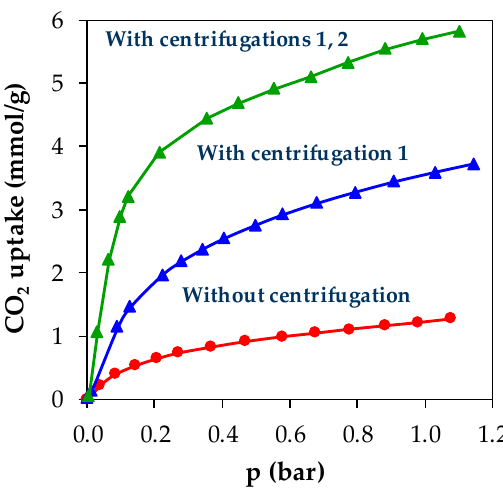
Figure 2. CO 2 adsorption isotherms of Ni-MOF-74 samples from the first-batch synthesis after washing repetitions (red) and the second-batch synthesis with centrifugation 1 (blue) and centrifugations 1 and 2 (green), in a pressure range of 0–1.2 bar and at 25 °C.